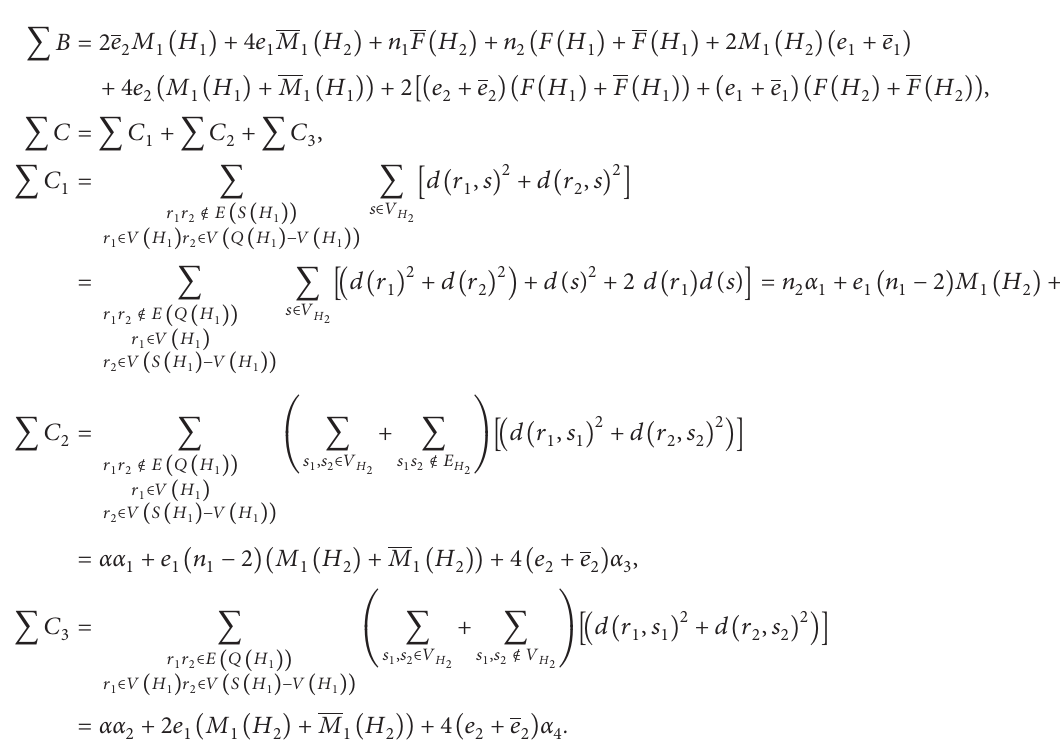
Figure 3: Graphical presentations of F -coincides for P blue, orange, gray, and yellow,